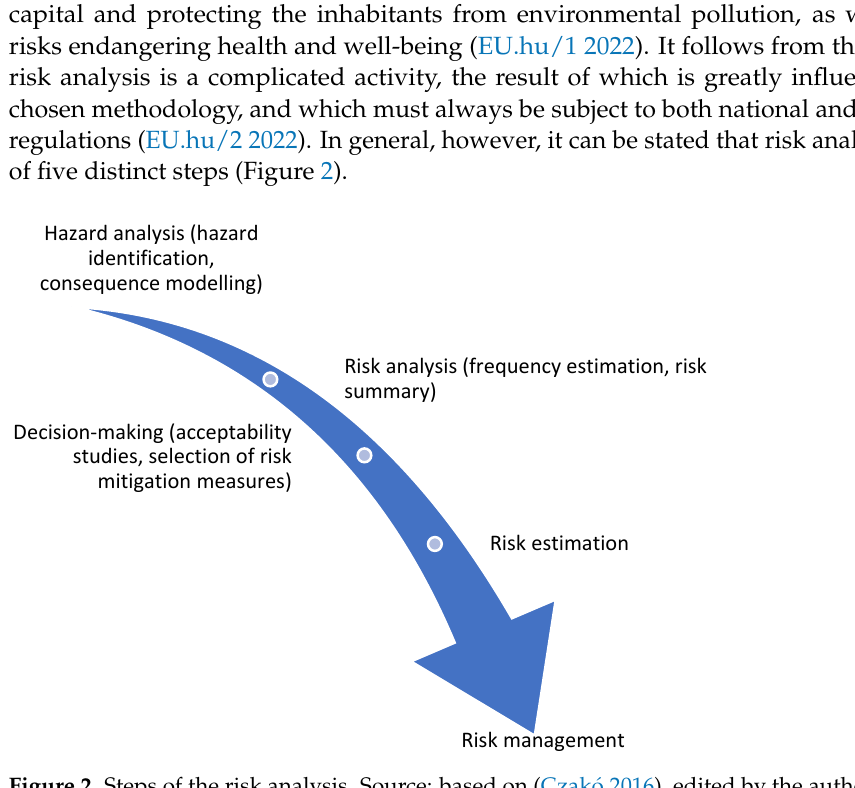
Figure 2. Steps of the risk analysis. Source: based on (Czak ó 2016), edited by the authors. In accordance with the ISO 31000:2018 (2018) standard, risk is defined as follows (Fekete 2015): a risk can be an event, an activity or the absence of an activity that may occur in the future and, if it occurs, will positively or negatively affect the achievement of